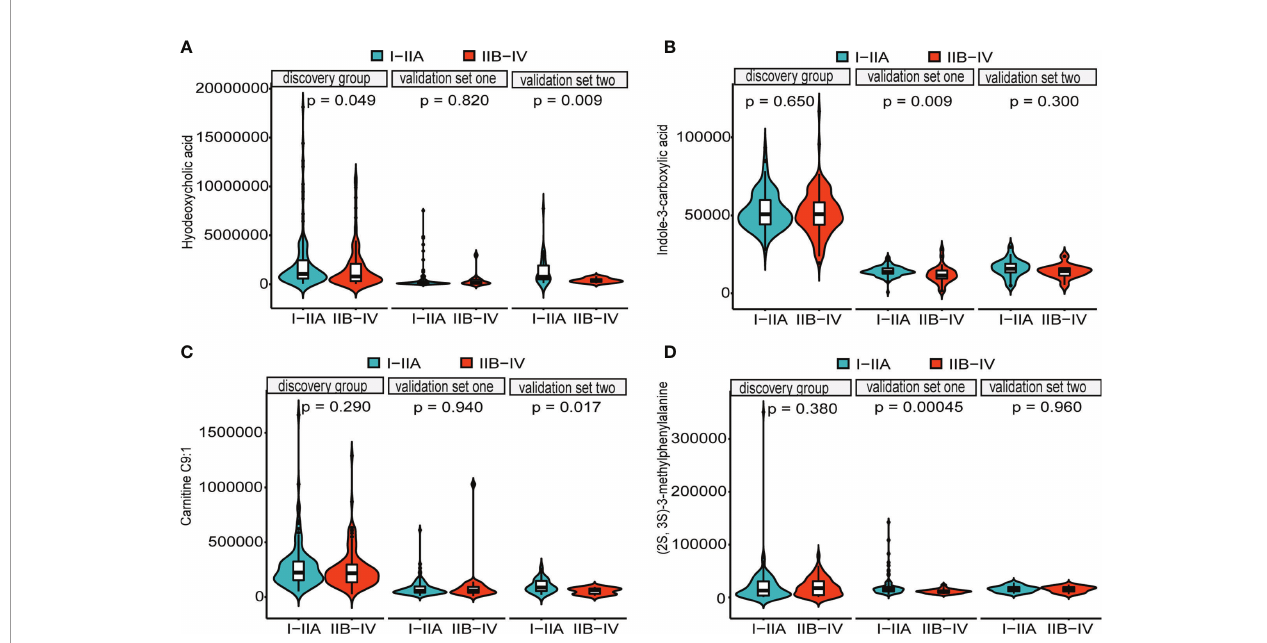
FIGURE 4 | Distributions of fi ve metabolites between early cancer and advanced cancer. Violin plots depicting the levels of hyodeoxycholic acid (A) , indole-3- carboxylic acid (B) , carnitine C9:1 (C) , and (2S,3S)-3-methylphenylalanine (D) . All of them were signi fi cantly higher in early cancer (I – IIA stage) (green) than in advanced cancer (IIB – IV stage) (orange) patients with ESCC ( p < 0.05, Wilcoxon test). Internal box plots represent median and interquartile range of metabolites across patients.